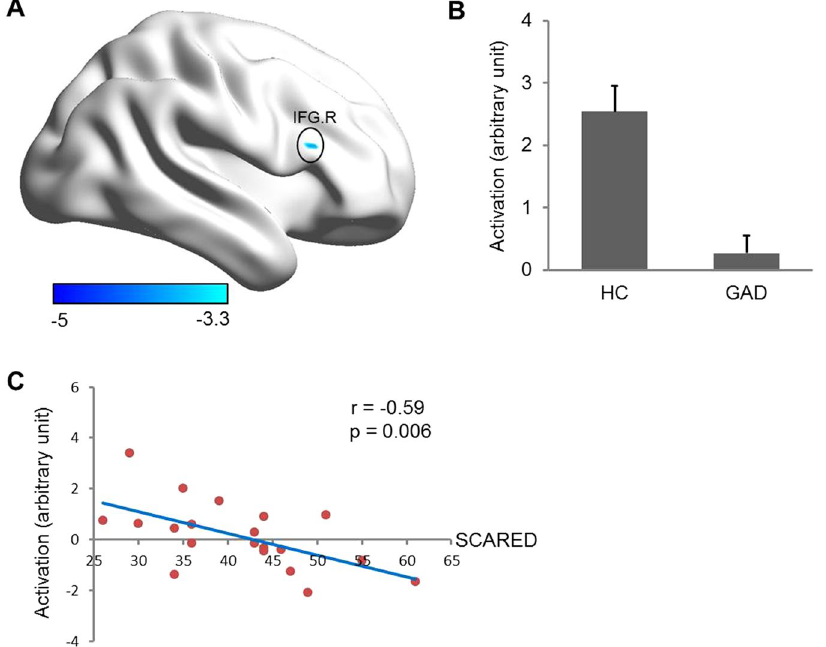
Figure 3. ( A ) Significantly decreased brain activation for the contrast of negative versus neutral in adolescents with GAD compared with HCs. We considered p < 0.05, AlphaSim corrected (i.e., p-voxel < 0.001 with minimum cluster size = 12 voxels) to be statistically significant. Color bar denotes t value. ( B ) Histogram shows the activation magnitude of right IFG in GAD patients and HCs. Error bar denotes the SEM. ( C ) Significant correlation was observed between activation magnitude of right IFG and SCARED scores in GAD patients. SCARED = Screen for Child Anxiety Related Emotional Disorders, IFG = inferior frontal gyrus, R = right, GAD = generalized anxiety disorder, and HCs = healthy controls.